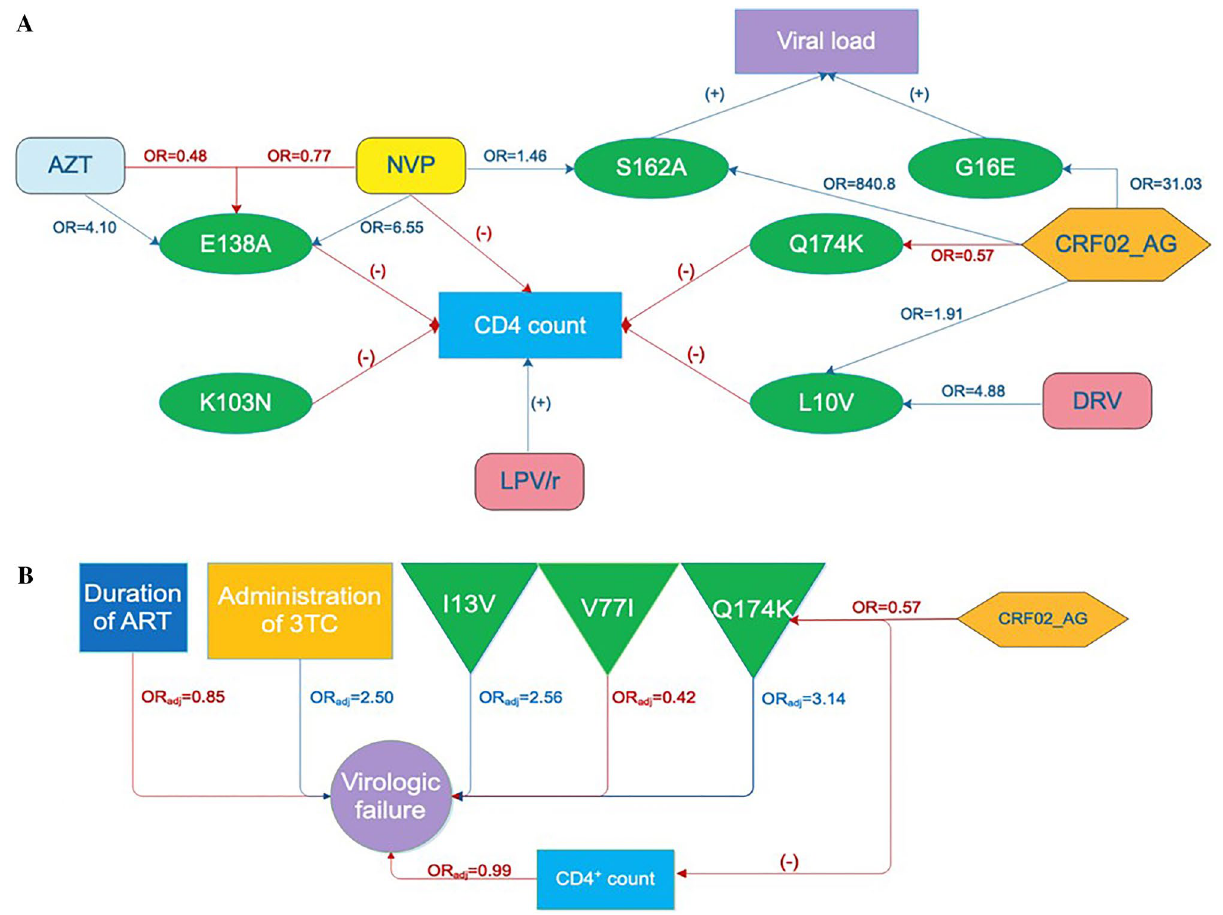
Figure 2. ( A ) Summary of the statistically significant associations between CD4 count, Viral load, ART components, Subtype and single mutations. Zidovudine (ZDV) is NRTI (light blue); Neviarpine (NVP) is NNRTI (yellow); Darunavir (DRV) and Lopinavir/Ritonavir (LPV/r) are PIs (pink); CRF02_AG is a subtype (orange); E138A, K103N, Q174K, S162A are RT ARTRMs (green), L10V, G16E are PI ARTRMs (green); OR odds ratio; (+) positive and (−) negative association from t-test (blue and red arrow, respectively. ( B ) A schematic representation of the effect of factors on the presence of virologic failure. I13V, V77I, Q174K are ARTRMs (green); OR adj adjusted odds ratio from multivariable